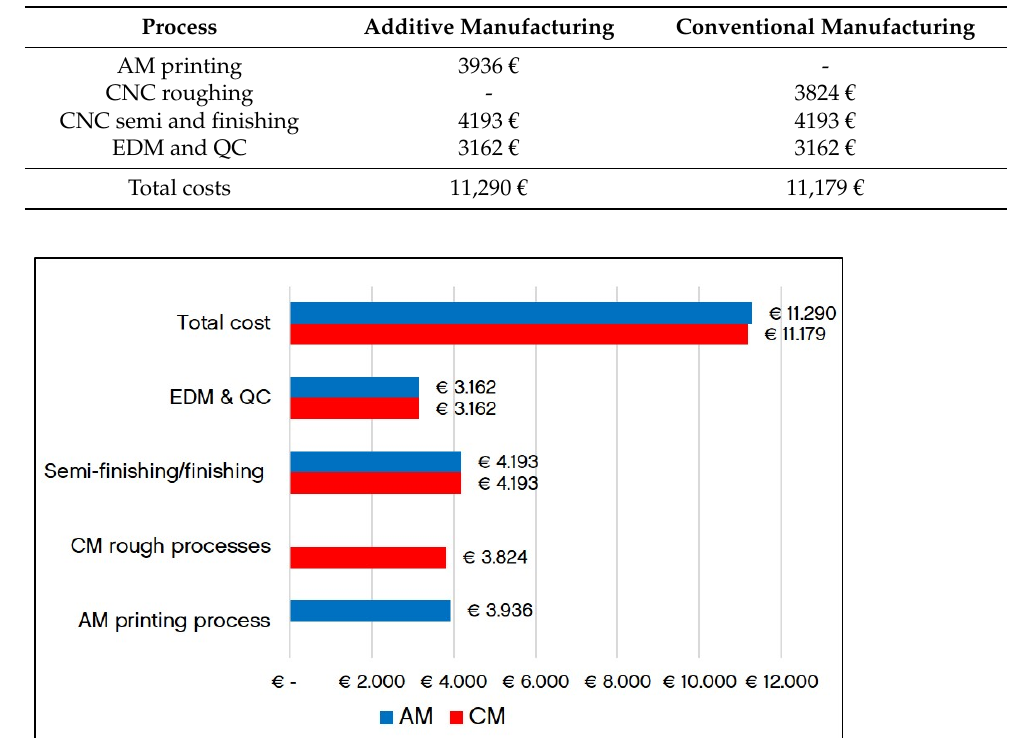
Table 2. Total AM and CM costs’ overview.